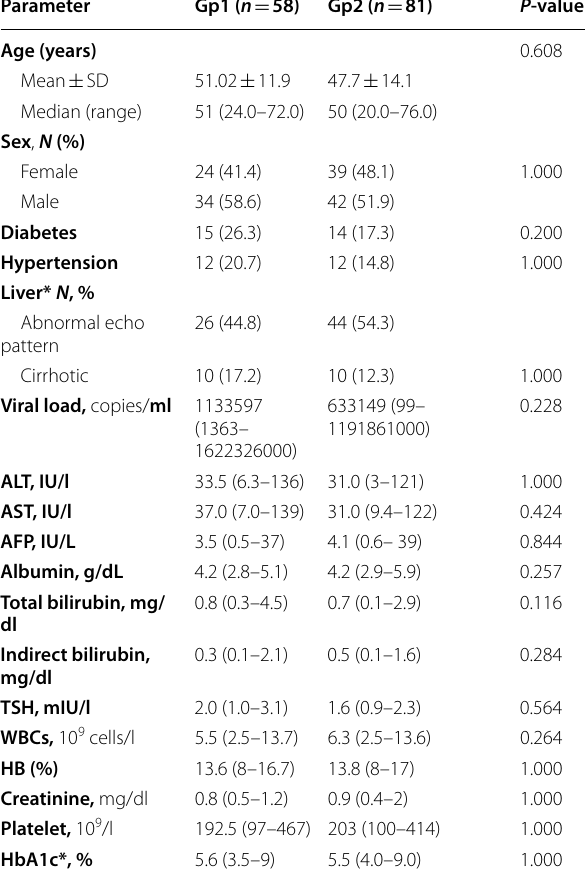
Table 1 Demographics and characteristics of the participants Table 2 Comparison between Gp1 and Gp2 parameters after 12th week of treatment